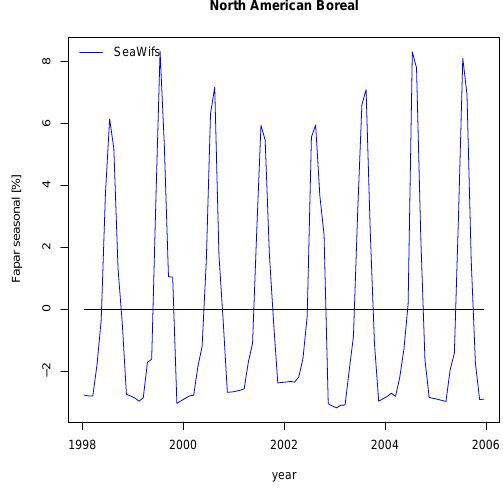
Fig. A1. Exemplar of determination of time of onset of the seasonal signal, zero centred, of the vegetation activity (SeaWiFS-FAPAR). Time series extracted from one grid cell located in North American Boreal.